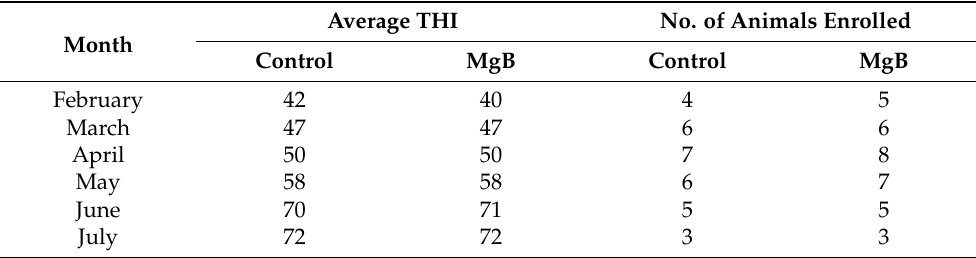
Table 1. Average temperature humidity index (THI) values and the number of animals enrolled in the study during the study period in the barns of magnesium butyrate (MgB; n = 34) and Control (n = 31)